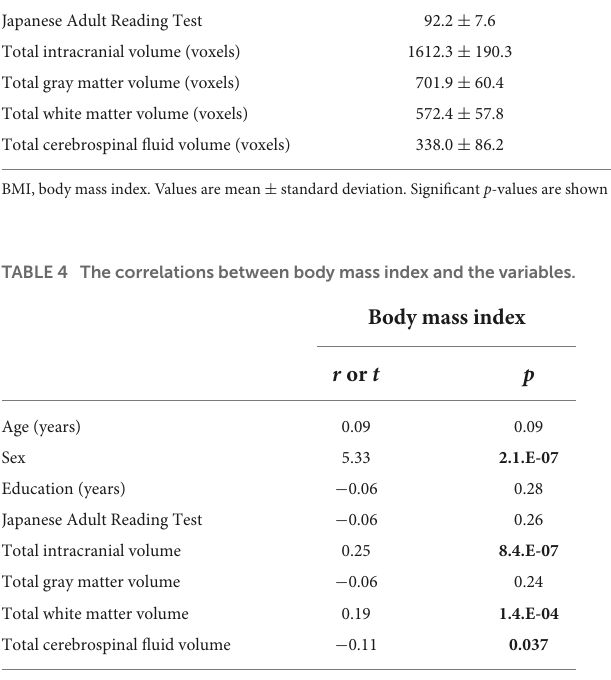
and total gray matter volume ( Figure 1B ). In VBM, BMI was significantly and negatively correlated with the bilateral cerebellum exterior volumes ( Figure 2A , corrected p < 0.01). There was no significant positive correlation between BMI and regional gray matter volume. In group comparisons, the bilateral cuneus and calcarine cortex, left cuneus, and left precuneus volume was significantly lower in the underweight group than in the non-underweight group ( Figure 2B , corrected p < 0.001). The right cerebellum exterior volume was significantly lower in the overweight or obese group than in the underweight or normal group ( Figure 2C , corrected p < 0.05), while there was no significant gray matter volume reduction in the obese group when compared to the non-obese group. No gray matter regions were significantly higher in the underweight, overweight or obese, or obese groups. There was no significant correlation between JART score and regional gray matter volume. Based on the VBM results in total participants, sex-related stratification analyses were further performed using the similar correlational and group comparison methods, controlling for age, JART score, and TICV. BMI showed no significant correlation with regional gray matter volume in men. The bilateral cuneus and calcarine cortex, left cuneus and calcarine cortex, and bilateral cuneus volume was significantly lower in underweight men than in non-underweight men (corrected p < 0.01), while the left thalamus proper volume was significantly lower in overweight or obese men than in underweight or normal men ( Figure 3 , corrected < 0.05). BMI was significantly and negatively correlated with the bilateral cerebellum exterior volumes in women ( Figure 4A , corrected p < 0.01). The right cerebellum exterior volume was significantly lower in overweight or obese women than in underweight or normal women (corrected p < 0.05), while the left cerebellum exterior volume was significantly lower in